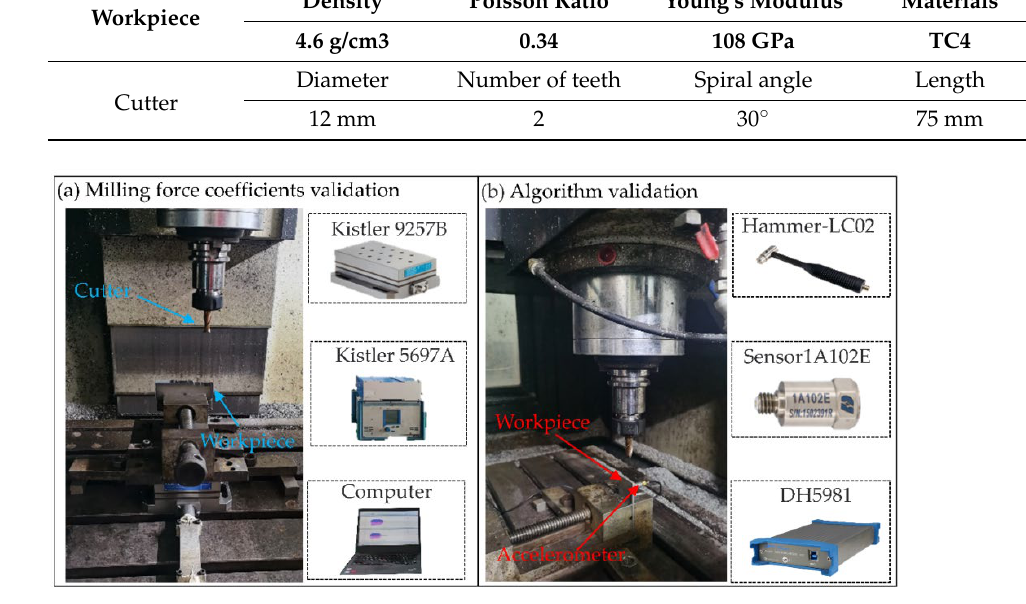
Table 2. Modal parameter identification errors under different external excitations.